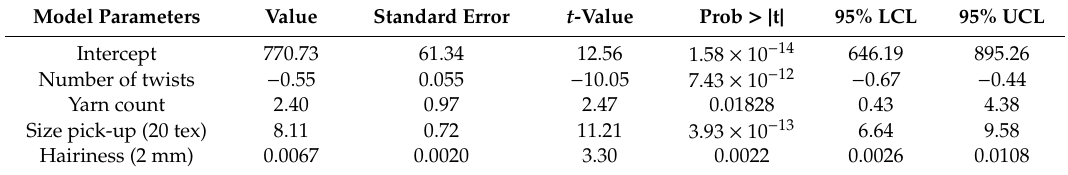
Table 10. Values of the coe ffi cient of regression model of variable Breaking force.